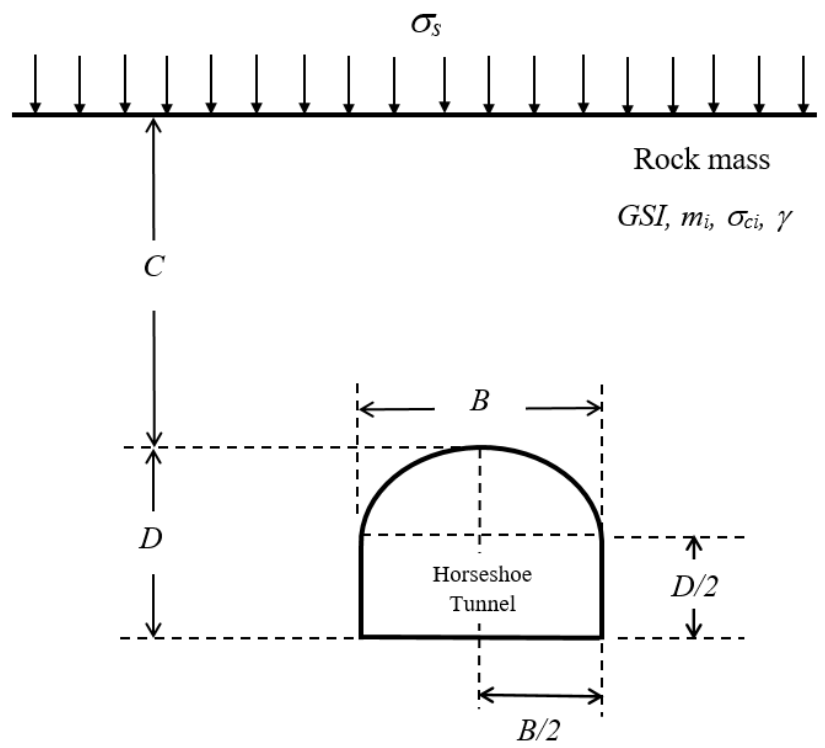
Figure 1. Problem description of a horseshoe tunnel.